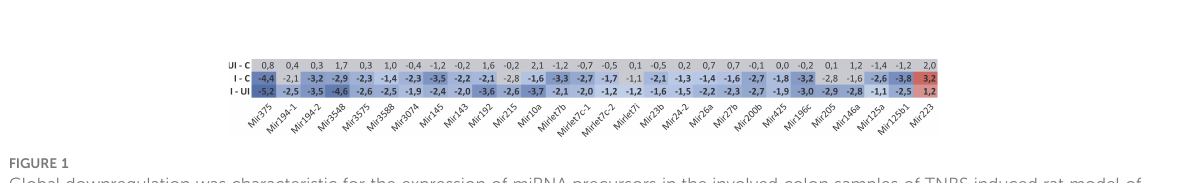
FIGURE 1 Global downregulation was characteristic for the expression of miRNA precursors in the involved colon samples of TNBS induced rat model of IBD as determined by RNA-Seq. Heat map shows expression alteration of miRNA precursors between control, TNBS treated unin fl amed and TNBS treated in fl amed rat colon samples. Values are given in logarithmic scale; red indicates at least 2-fold signi fi cant increase ( ≥ log 1; p < 0.05), blue indicates at least 2-fold signi fi cant decrease ( ≤ log -1; p < 0.05), gray labels non-signi fi cant change ( p ≥ 0.05) in expression level. Abbreviations as “ UI – C ” , “ I - C ” and “ I – UI ” represent the TNBS treated – unin fl amed (UI) vs. control (C), TNBS-treated – in fl amed (I) vs. control (C) and TNBS treated - in fl amed (I) vs. TNBS treated – unin fl amed (UI) rat colon sample